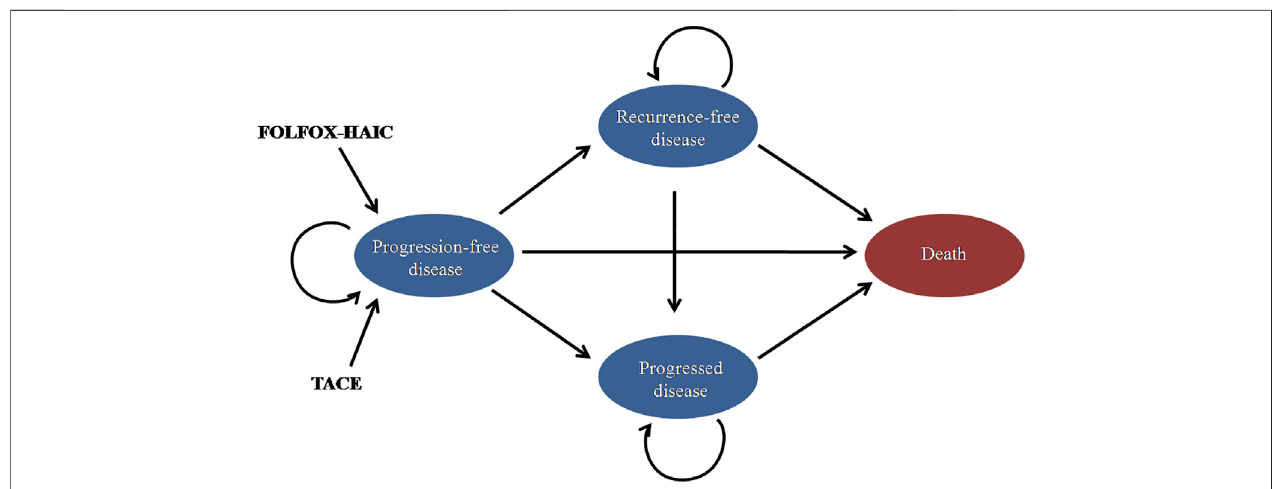
FIGURE1| |State-transitiondiagramforlargeunresectablehepatocellularcarcinoma.Thefourmainhealthstatesarerepresentedbyovals.Patientsmaytransition from “ progression-free disease ” to “ recurrence-free disease, ”“ progressed disease, ” or “ death. ” TACE, transarterial chemoembolization; FOLFOX-HAIC, hepatic arterial infusion chemotherapy with infusional fl uorouracil, leucovorin, and oxaliplatin.